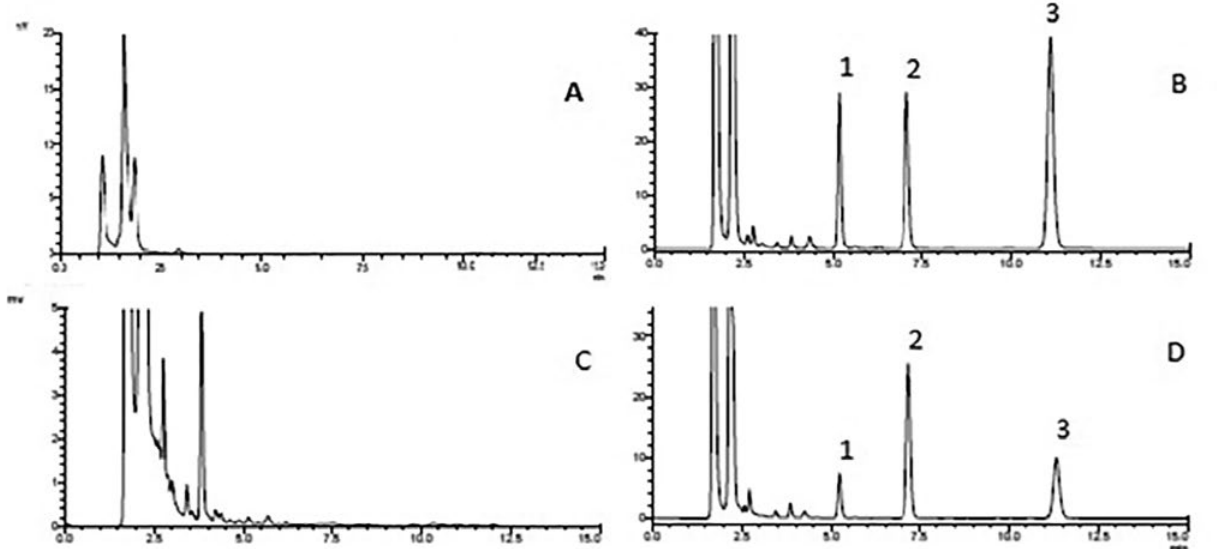
FIGURE 2 - HPLC profiles of diclofenac and its metabolite 4-hydroxy diclofenac in rats and in human recombinant CYP2C9 yeast cells. A. Blank plasma; B. Blank plasma spiked with reference substance; C. Sample before administration of diclofenac; D. Sample 15min after administration of Diclofenac+Bifendate. 1. 4’-hydroxydiclofenac 2. Bifendate 3.